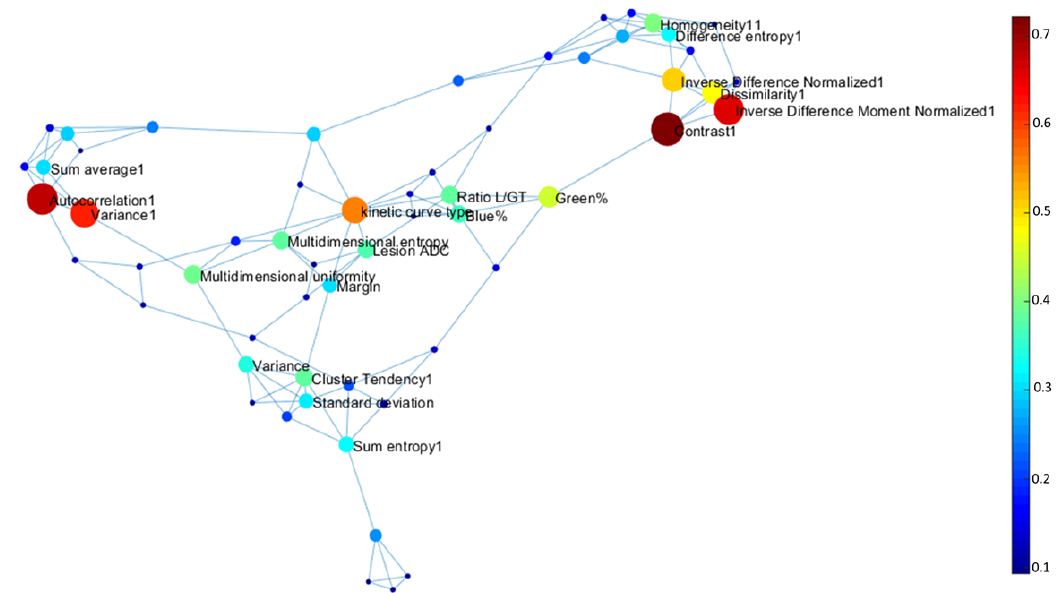
Figure 9. Visualization of the Integrated Radiomic Informatic System (IRIS) mpRad complex interaction network. The nodes represent different IRIS parameters, with edges corresponding to inter-parametric relationships.